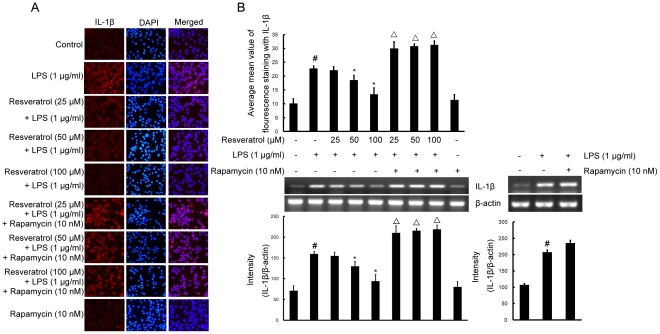
mTOR is involved in resveratrol-attenuated the production of the proinflammatory cytokine IL-1β at the transcriptional and translational levels in BV-2 cells.Panel A shows the immunofluorenscence images for protein expression of IL-1β and Panel B shows the corresponding mRNA data. The relative mRNA level was quantified by scanning densitometry and normalized to β-actin mRNA. Note the up-regulated protein and mRNA expression of IL-1β by LPS is suppressed by different concentrations of resveratrol; however, in cells pretreated with mTOR inhibitor rapamycin, the suppressive effect of resveratrol is abrogated. The values shown are mean ± SEM of data from three independent experiments. #Significant compared with control alone, p<0.05. *Significant compared with LPS alone, p<0.05. ▵Significant compared with resveratrol+LPS, p<0.05.